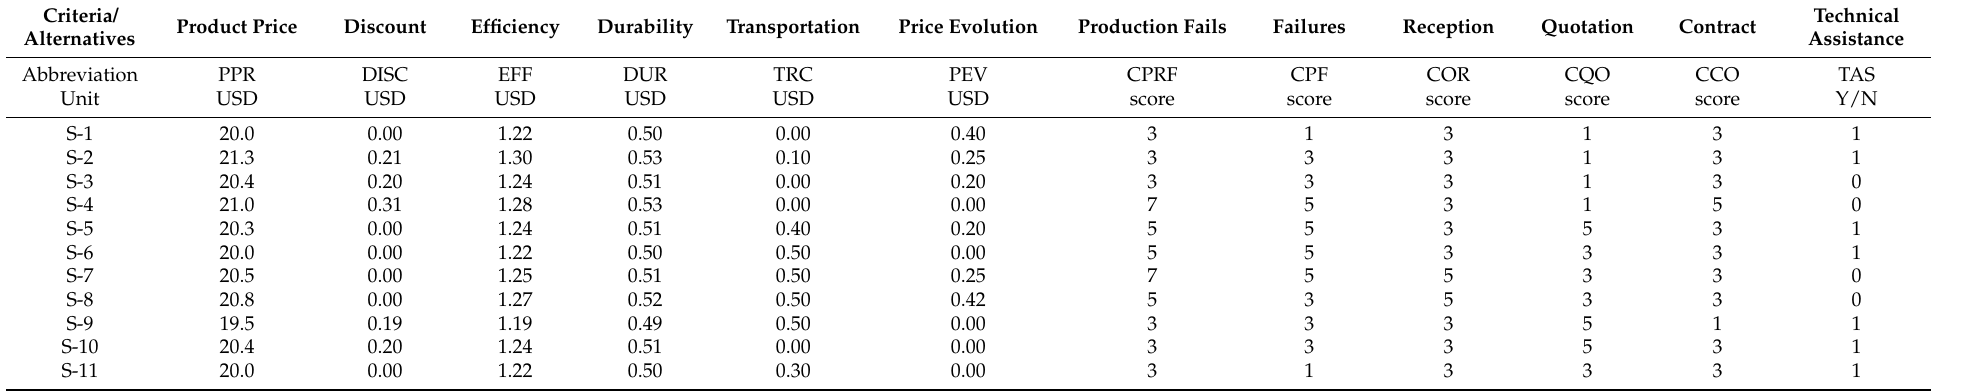
Table 4. Input Matrix for Product Chemical